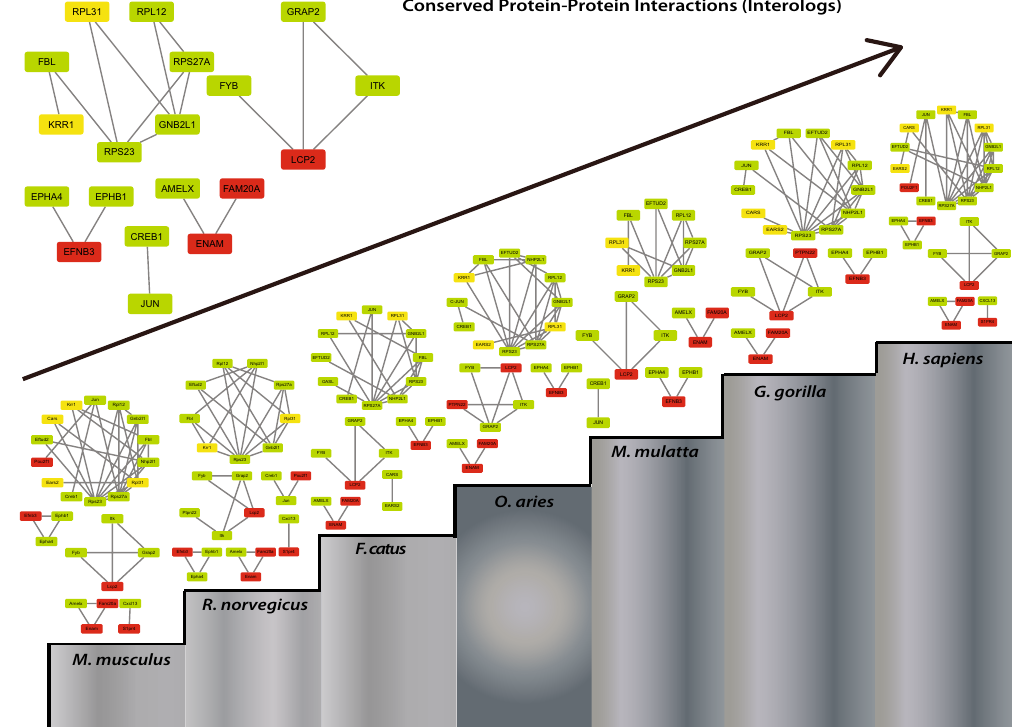
Figure 7. Interologs in the network from lower to higher organisms. Nodes in yellow are seed genes and nodes in red are seed genes that are the key regulators. Nodes in green are the interacting partners of seed